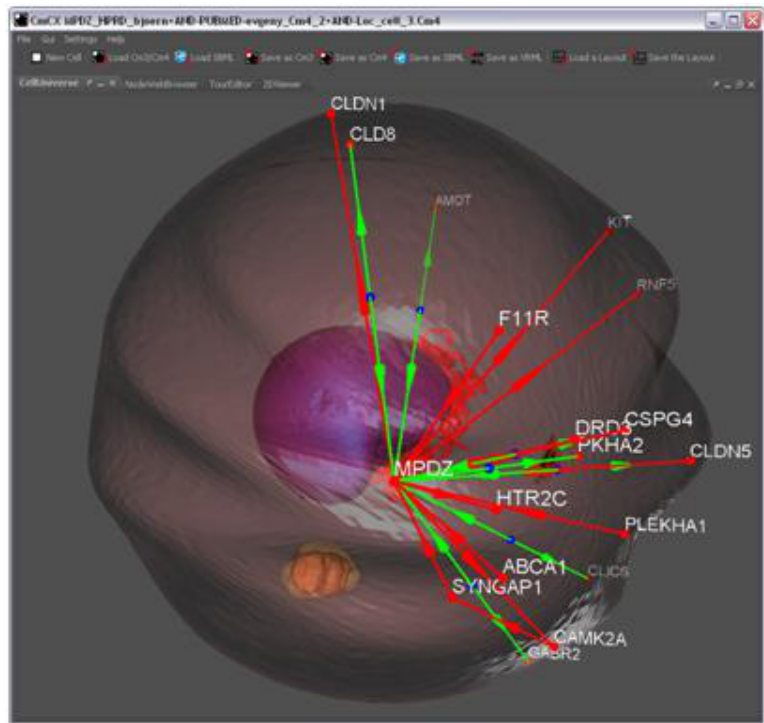
Figure 9: This CmPI visualization shows the localized network as shown in Fig. 7. The red network comes from VANESA, the green from ANDVisio. All enzymes are localized at the cell membrane. SYNGAP1, originally localized at the cytosol, can also be mapped directly onto the cell membrane by combining the newly gained knowledge.